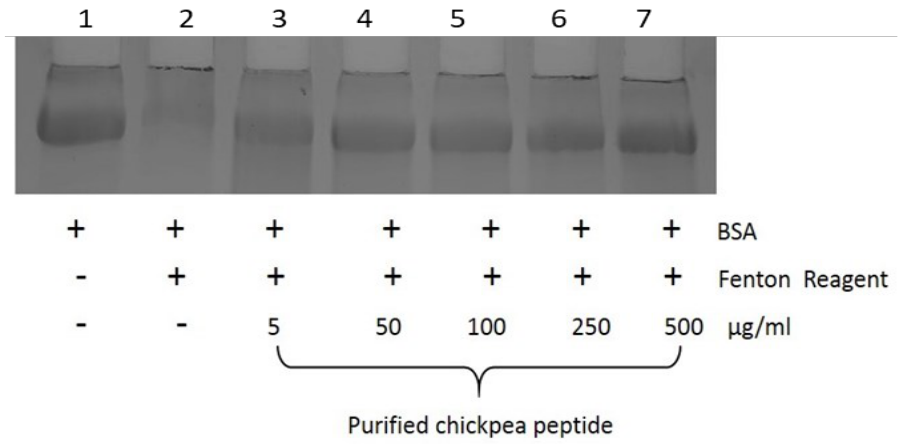
Figure 13. SDS-PAGE; Effect of chickpea peptide protection against ·OH generated photolysis of H 2 O 2.